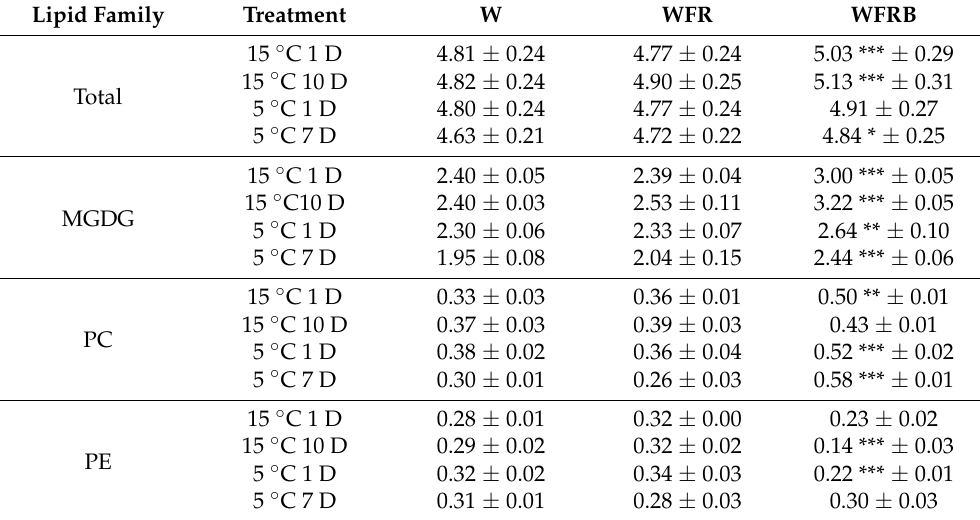
Table 2. Changes of MGDG, PE and PC lipid classes and total DBI content in barley leaves after supplementary FR and Blue light treatments at different temperatures. In all cases, the treatments were compared to the first-day samples in the control W (15 ◦ C 1 D). The samples were illuminated with white light, white light supplemented with far-red light (WFR) or combined far-red with additional blue light (WFRB). In addition to light treatment, 5 ◦ C treatments were also made. The samples were taken on the first and last days of the treatment, which was ten days at 15 ◦ C and seven days at 5 ◦ C. In all cases, the leaf samples were cut from the central part of the second youngest leaf. Statistical analysis was performed with multiple-way ANOVA followed by Dunnett’s post-hoc test. Measurements were made on 3 to 5 independent biological replicates ( ± SE). Significance levels are indicated by * p < 0.1 and ** p < 0.05 and *** p <